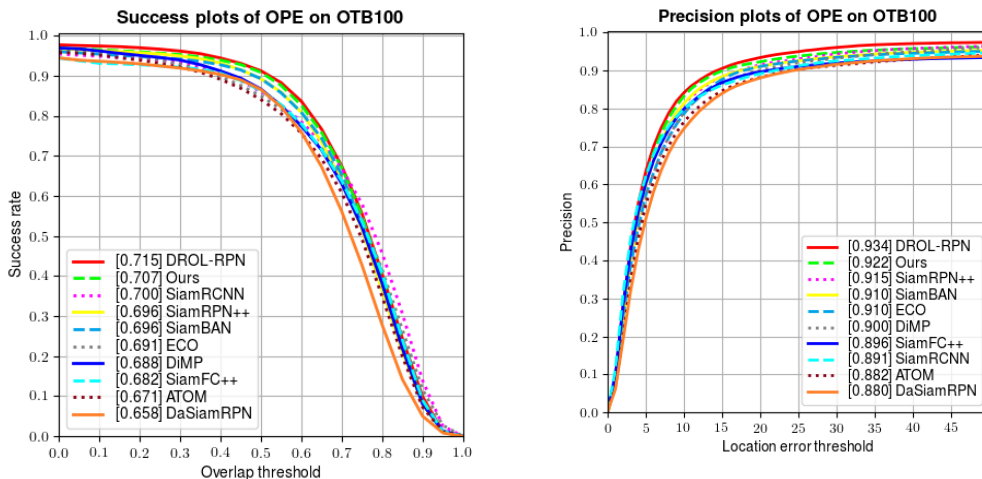
Figure 5. Comparative results of success rates and precision on OTB100.